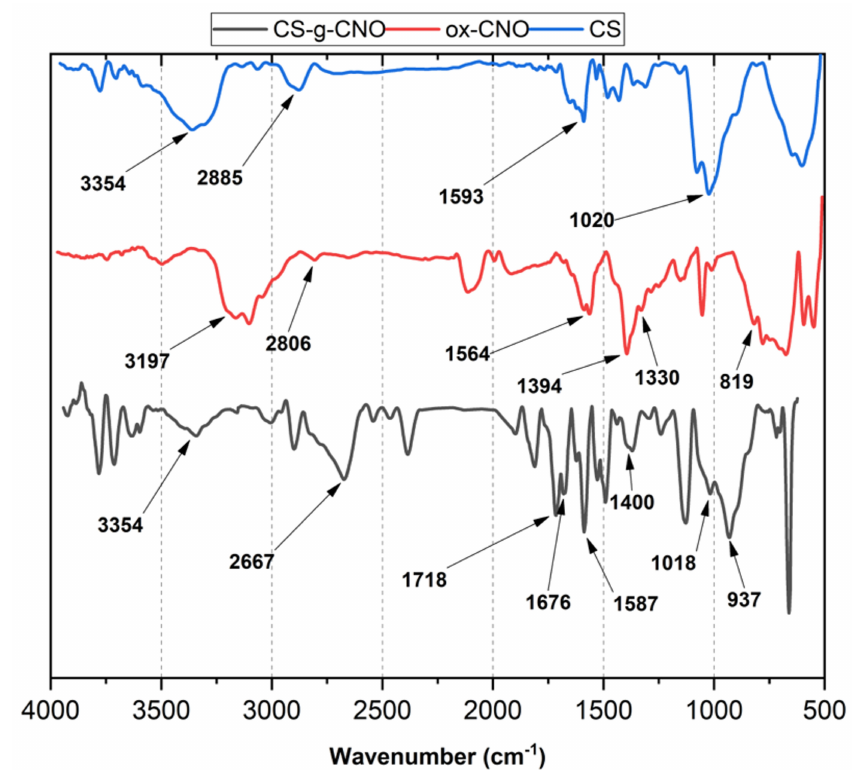
Figure 2. Attenuated total reflectance Fourier-transform infrared spectroscopy (ATR-FTIR) of CS, ox-CNO, and